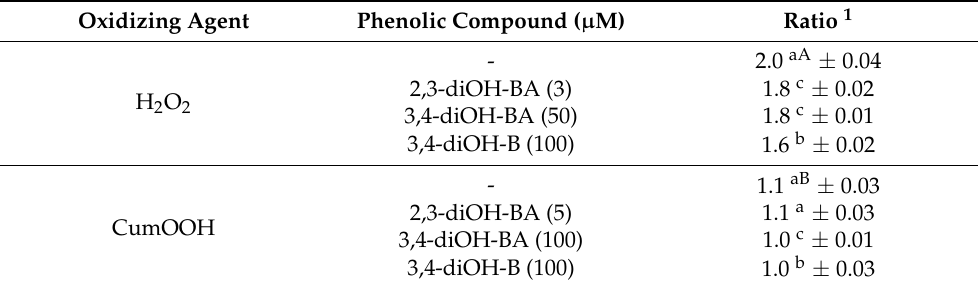
Table 4. TBARS levels (expressed as µ mol malondialdehyde per mg protein) in S. cerevisiae BY4741 cells treated with H 2 O 2 (5 mM) or CumOOH (150 µ M) in the absence/presence of the tested phenolic